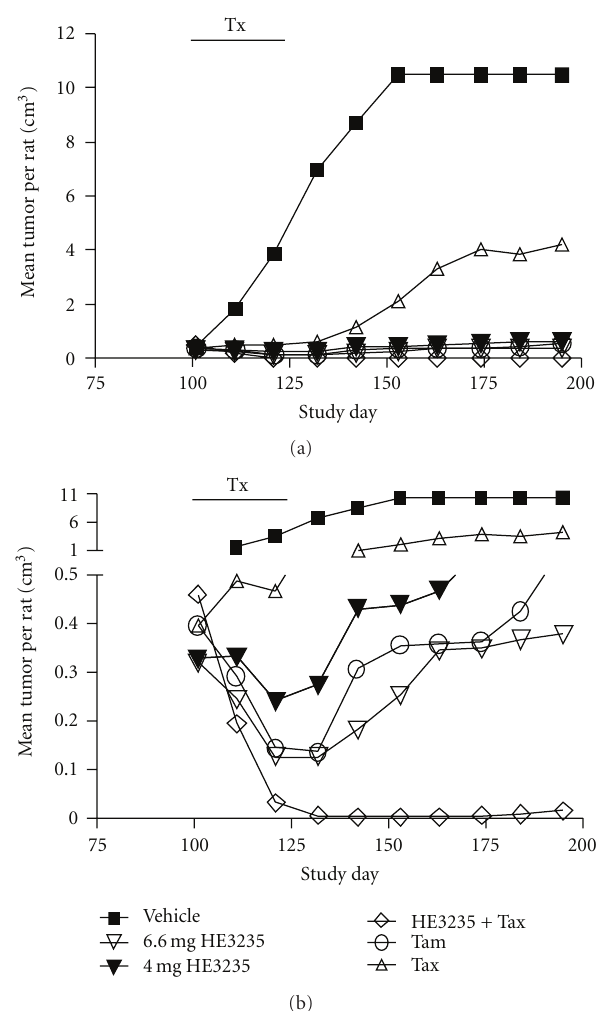
Figure 2: Tumor volume in response to treatment. Seven-week- old female Lewis rats were treated with a single IP injection of 50mg/kg MNU. Tumors developed for 90 days, prior to treatment ( n = 13) for 28 days with (1) cyclodextrin vehicle daily, (2) 6.6mg HE3235 daily, (3) 4 mg HE3235 daily, (4) 6.6 mg HE3235 daily + 1.5mg docetaxel weekly, (5) 1.5mg docetaxel weekly, (6) 2.5mg anastrazole daily, and (7) 0.25mg tamoxifen weekly. HE3235 in combination with docetaxel was more e ff ective than comparator monotherapies at decreasing the mean tumor volume per animal. Upper graph, all results plotted full scale; lower graph, split and expanded Y -axis. Anastrazole results were similar to docetaxel, but not plotted to improve clarity. The mean tumor volume for vehicle on day 101 was 0.41cm3, which was not plotted to improve